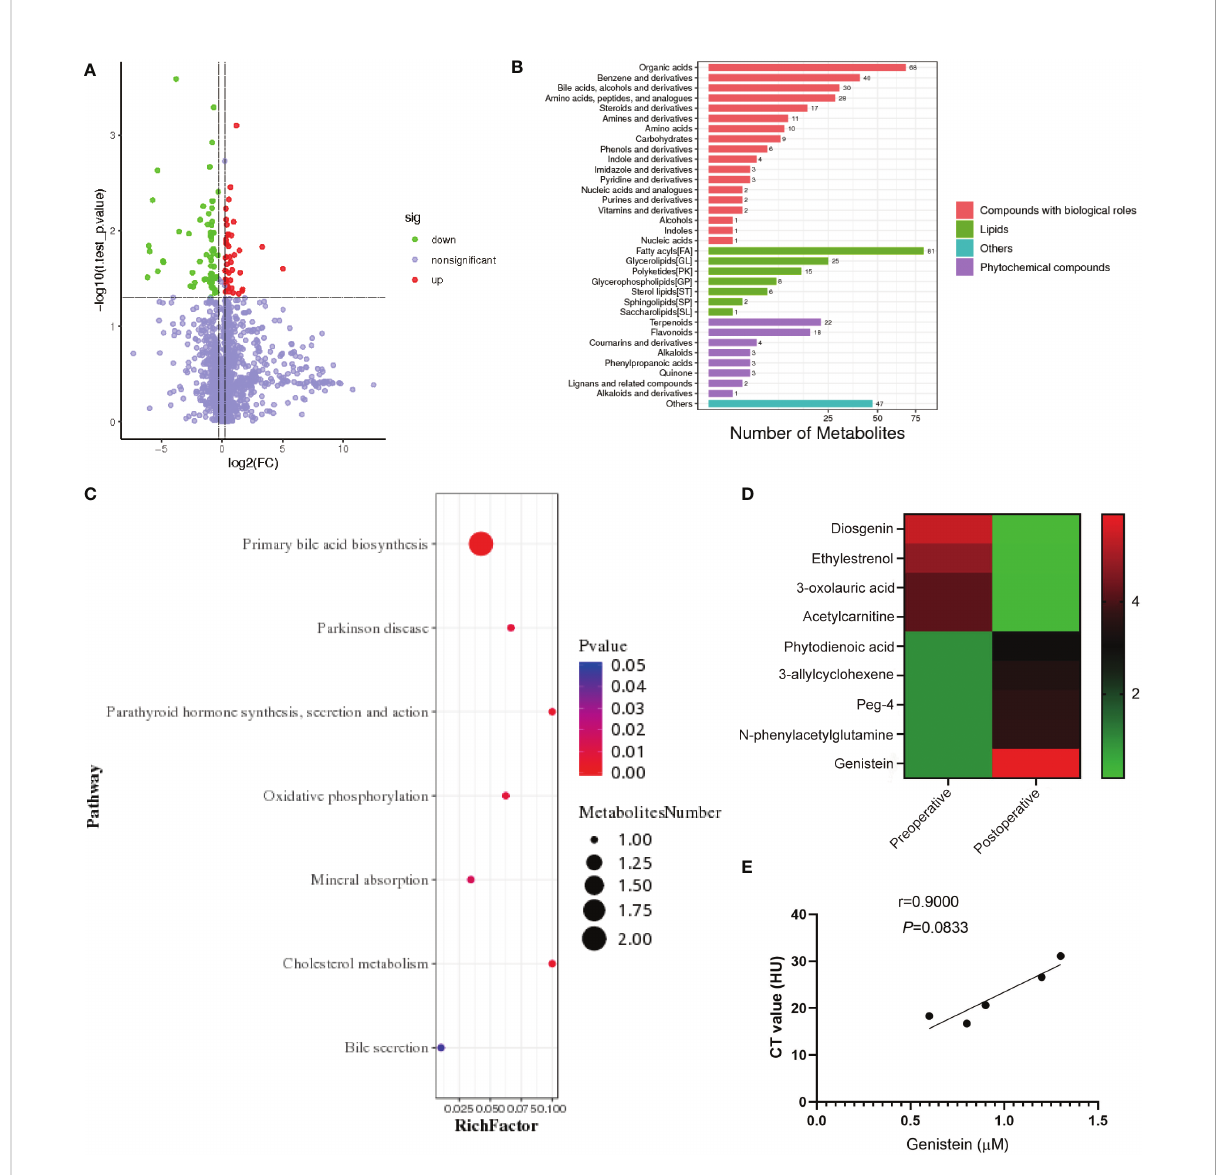
FIGURE 2 Plasma and local levels of genistein are increased after SG in patients with obesity. (A) Metabolite volcano map before and after SG in patients with obesity. (B) KEGG shows the affection of SG on metabolism in patients with obesity. (C) Analysis of the effect of SG on metabolism in patients with obesity. (D) Heatmap of relevant differential metabolites before and after SG. (E) Correlation analysis of the NAFLD degree and genistein abundance in patients with obesity. Spearman correlation was performed to study the relationship. Data are presented as mean ± SEM, **p < 0.01, ***p<